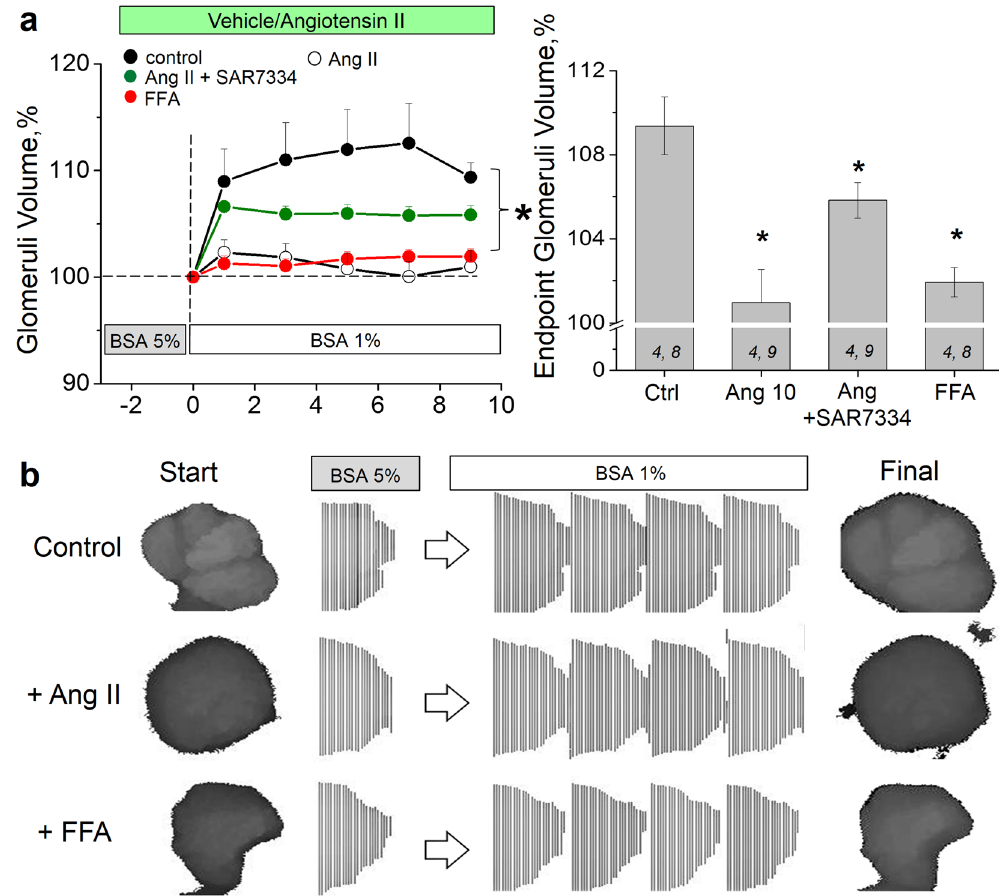
Figure 3. Effects of flufenamic acid and SAR7334 on rat glomeruli volume. ( a ) The effects of activation of TRPC6 channels by flufenamic acid (100 µ M, FFA) or their blockage by SAR7334 (1 µ M) on Ang II–induced glomeruli volume dynamics (left panel), and a summary plot for the endpoint glomeruli volume (right panel). ( b ) Representative reconstituted glomerular volumes and combined z-stacks illustrating the changes in the volume of a single glomerulus during the solution change from 5% to 1% BSA in control, and upon incubation with Ang II and